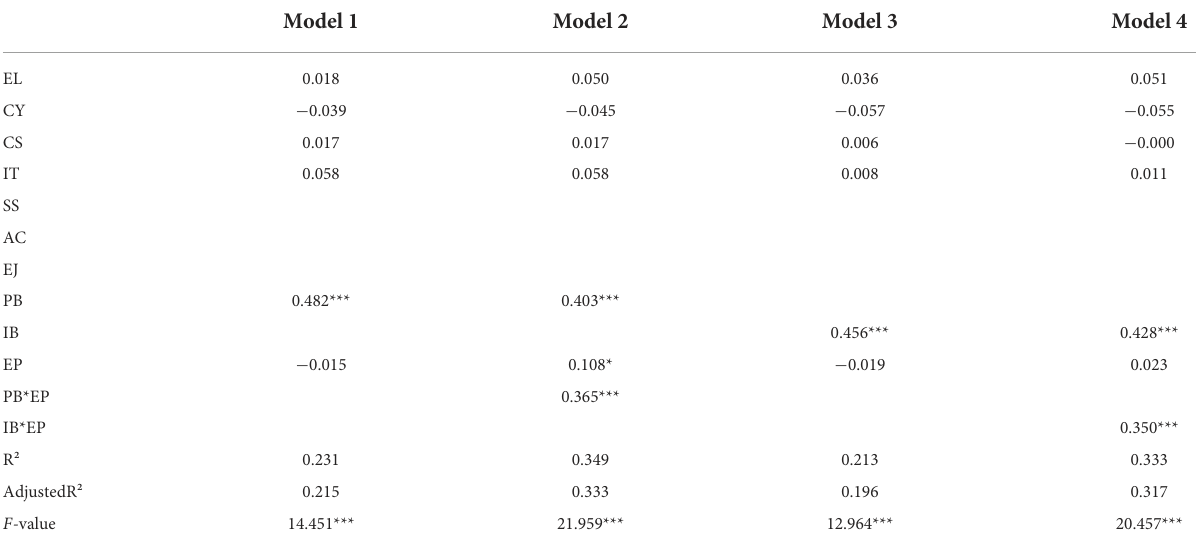
TABLE 5 Results of hierarchical regression analysis of moderating